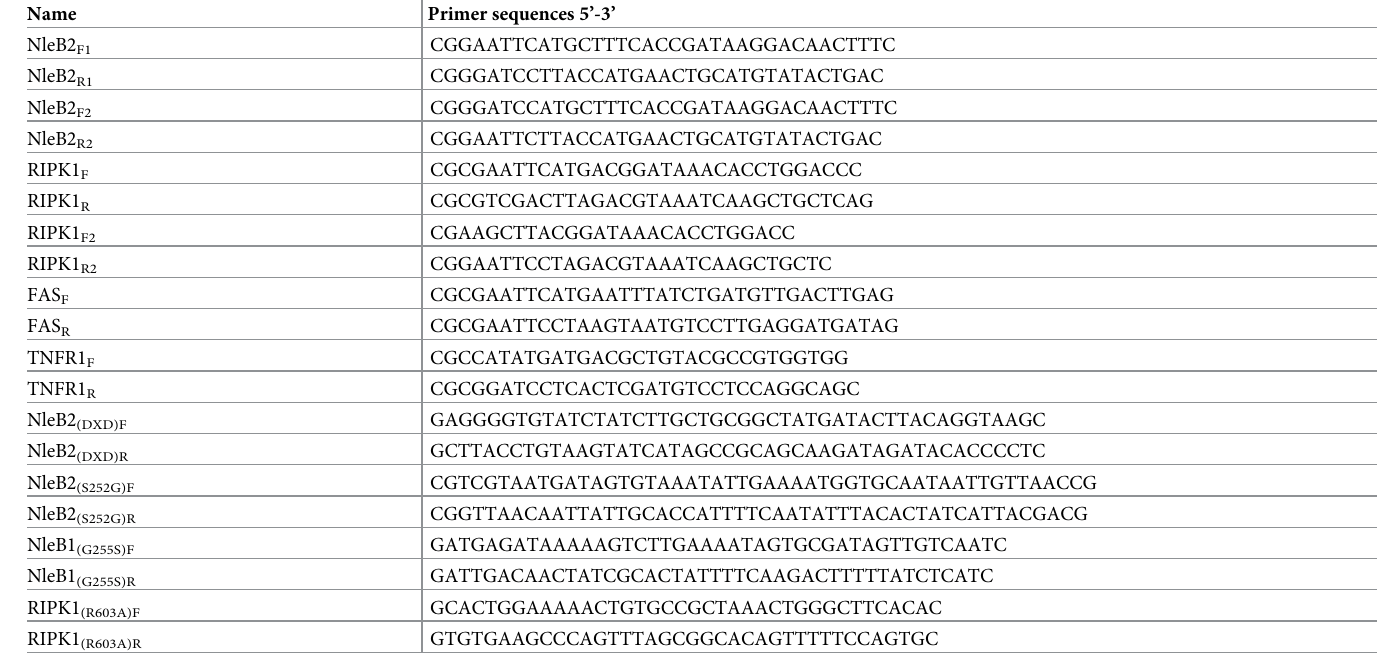
Table 2. List of primers used in this study. Name Primer sequences